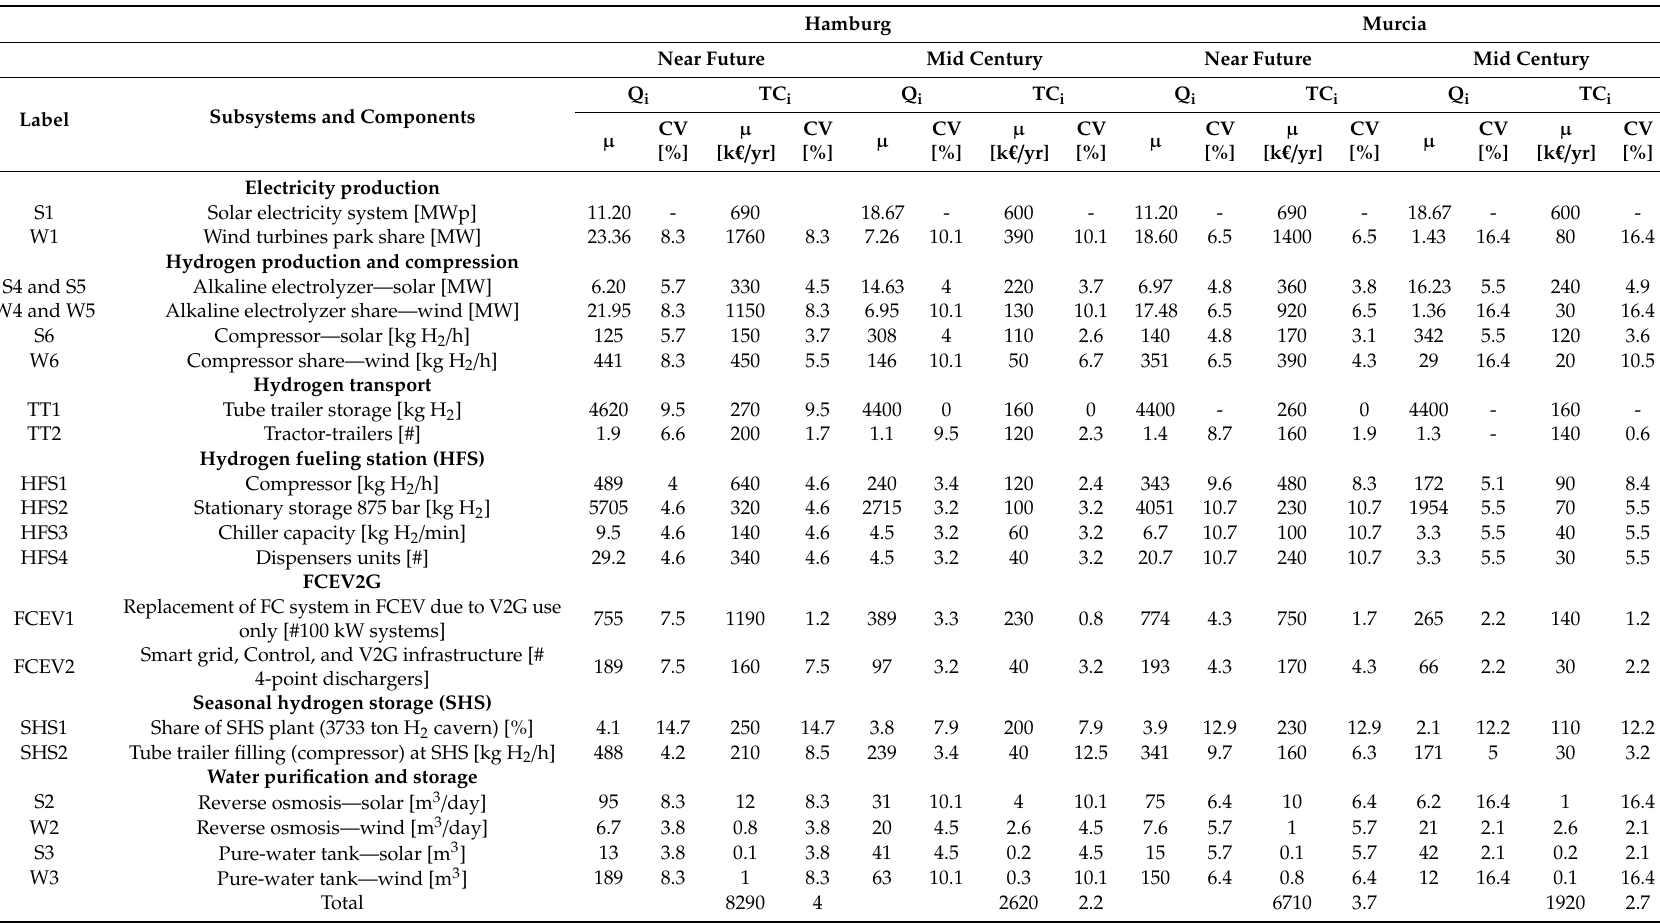
Table A7. Installed component capacities (Q) and component total annual costs (TC i ) in the smart city area Hamburg and Murcia in the Near Future and Mid Century scenario, 2012–2016 average ( µ ) and coe ffi cient of variation